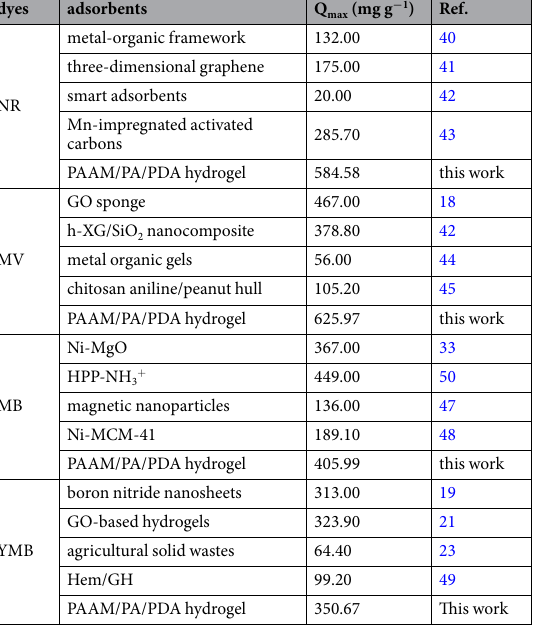
Table 1. Maximum adsorption capacities of various adsorbents toward NR, MB, MV and